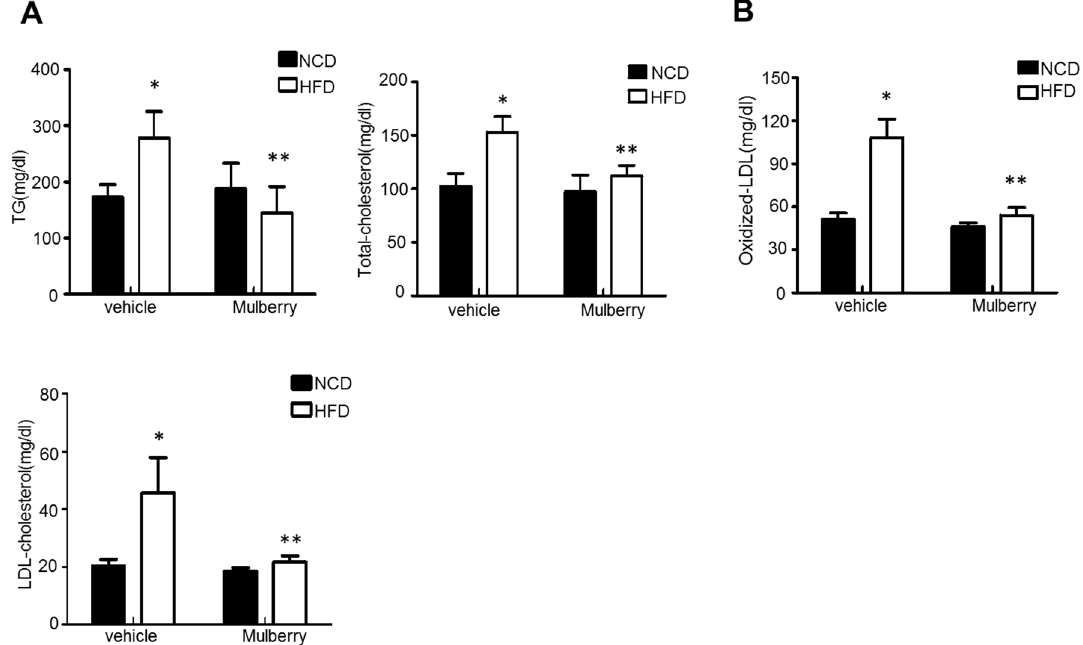
Figure 2. Mulberry prevents high-fat diet (HFD)-induced hepatic steatosis. Rats were fed a normal diet or a high-fat diet with or without 100 mg/kg mulberry for six weeks, and serum and liver were harvested. ( A ) Biochemical analysis of serum samples. Levels of triglycerides (TG), total cholesterol (TC) and low-density lipoprotein (LDL)-c were measured in the serum of rat in different experimental groups. Values are presented as mean ± SEM. ( n = 6, * p <0.05 versus the normal chow diet (NCD) group, ** p <0.05 versus the HFD group) ( B ) Levels of oxidized-LDL were measured in the serum of rat in different experimental groups. Values are presented as mean ± SEM. ( n = 6, * p <0.05 versus the NCD group, ** p <0.05 vs. the HFD group).